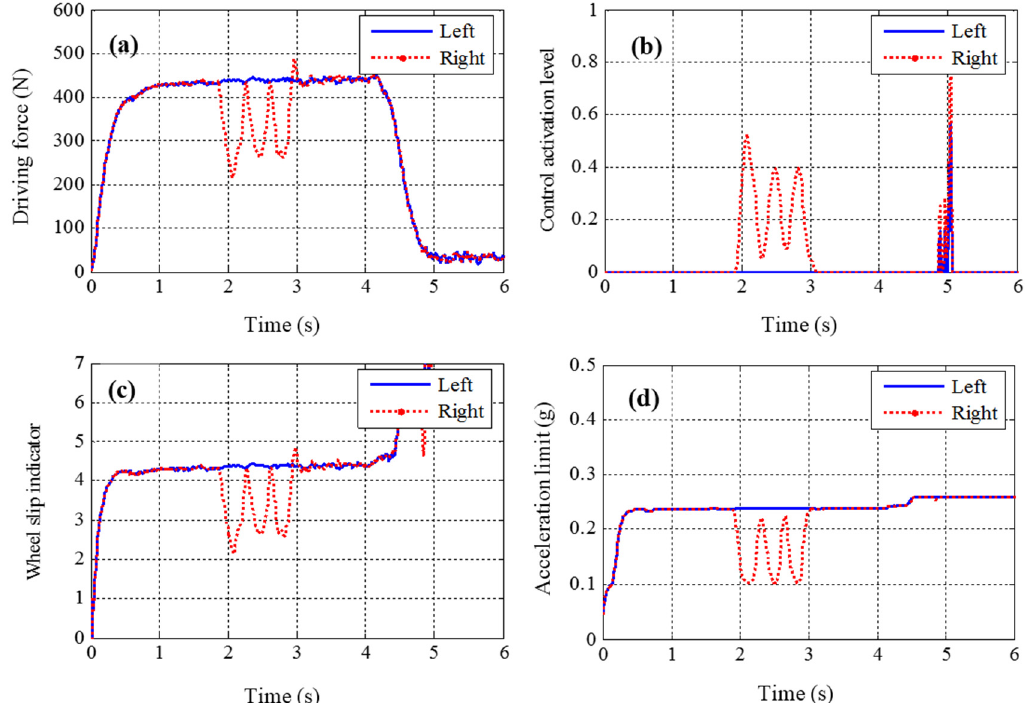
Figure 10. ( a ) Estimated driving force. ( b ) Control activation level obtained from Equation (18). ( c ) Wheel slip indicator (estimated from RLS algorithm). ( d ) Updated acceleration limit.